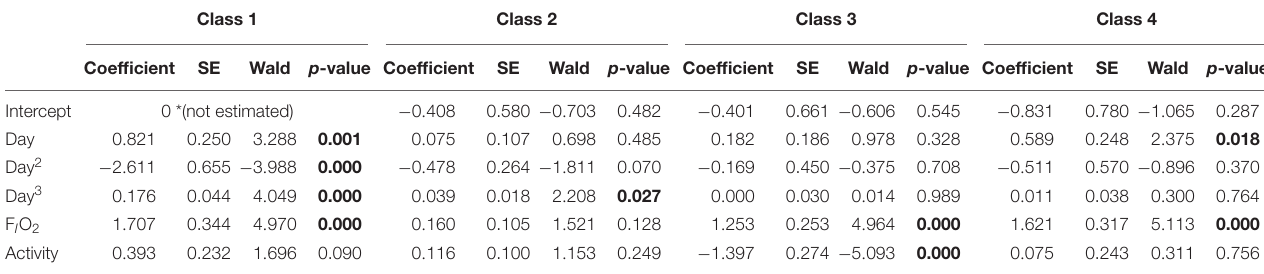
TABLE 5 | The fixed effects in the longitudinal model for TMD, NA, and